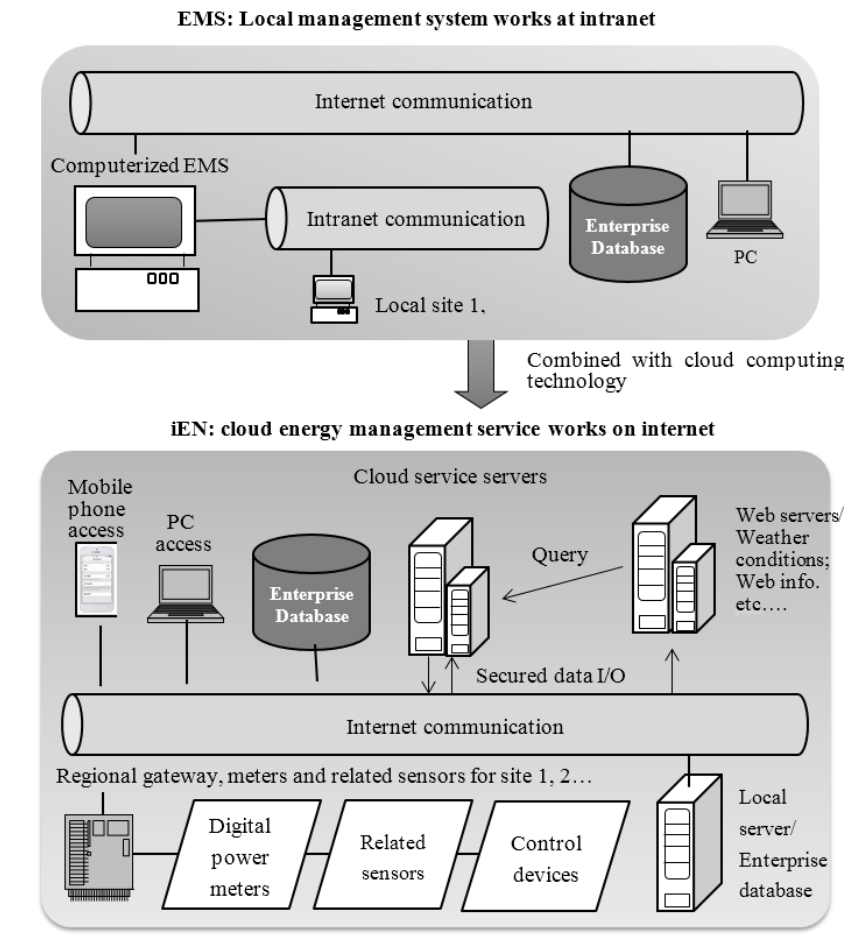
Figure 1. The evolution of cloud